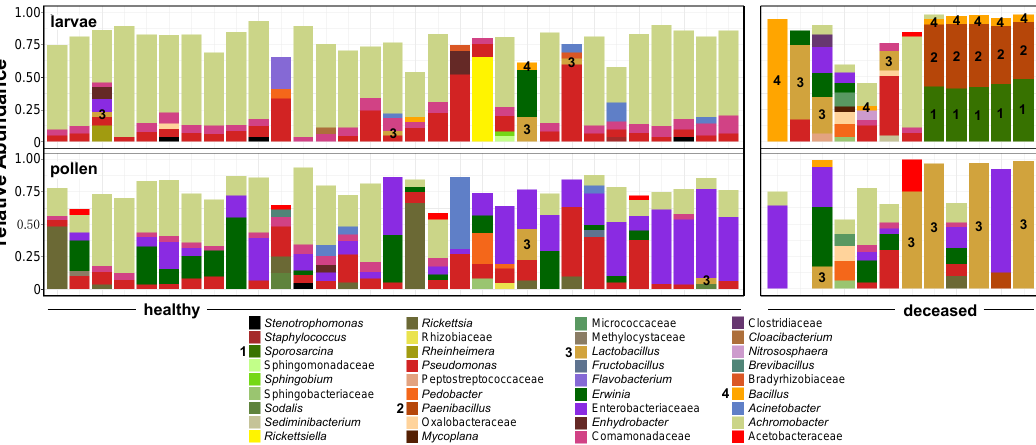
Figure 2. Bray–Curtis-based non-metric multidimensional scaling (NMDS) ordinations of larvae, pollen, and soil pellets acquired from O. bicornis nest chambers, where 31 contained healthy larvae and 12 contained deceased larvae.